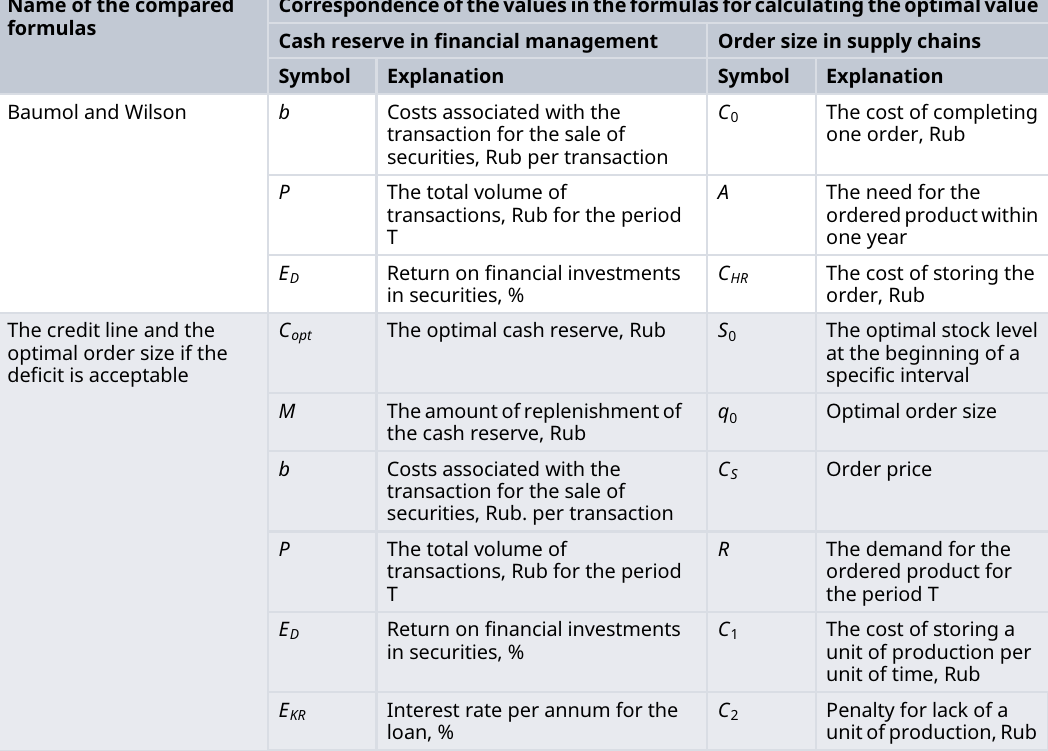
Table 2. Values in the formulas for calculating the optimal margin. Name of the compared